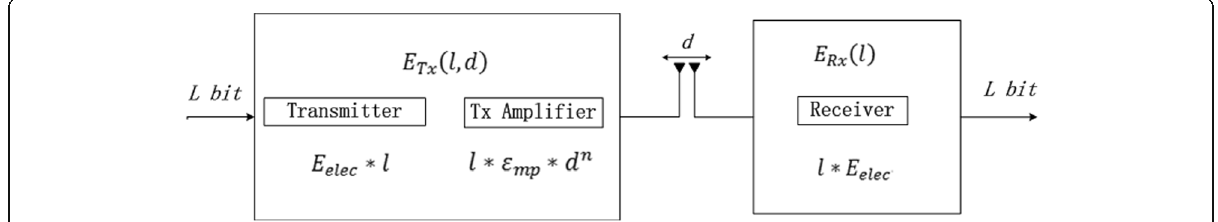
Fig. 1 Communication energy consumption model of WSN. This figure demonstrates the radio energy model which is cast-off to evaluate the APTEEN as well as various APTEEN in this